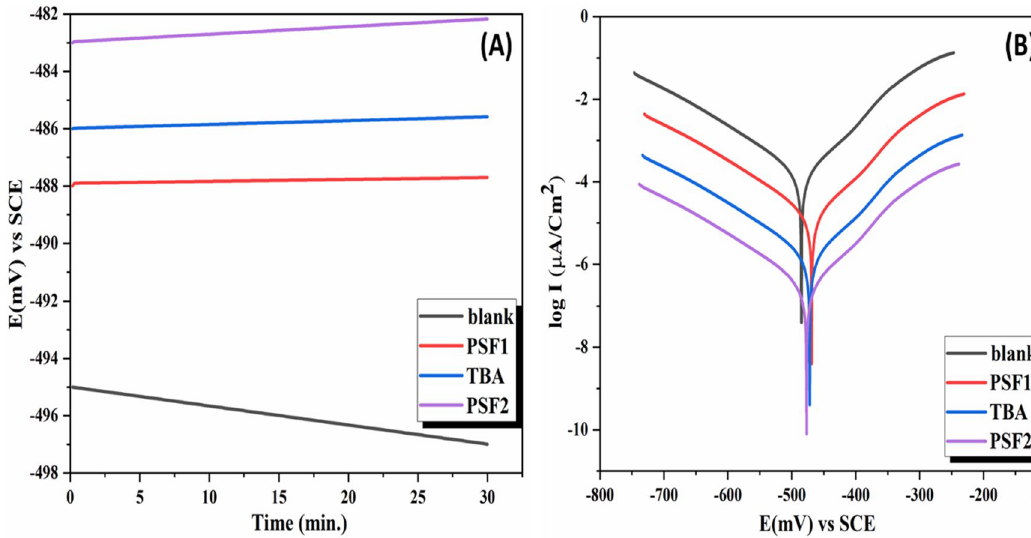
Figure 9. ( A ) Potential-time curves and ( B ) Tafel plots polarization curves of mild steel exposed to different inhibitors at 200 ppm for TBA, PSF1, and PSF2. Media